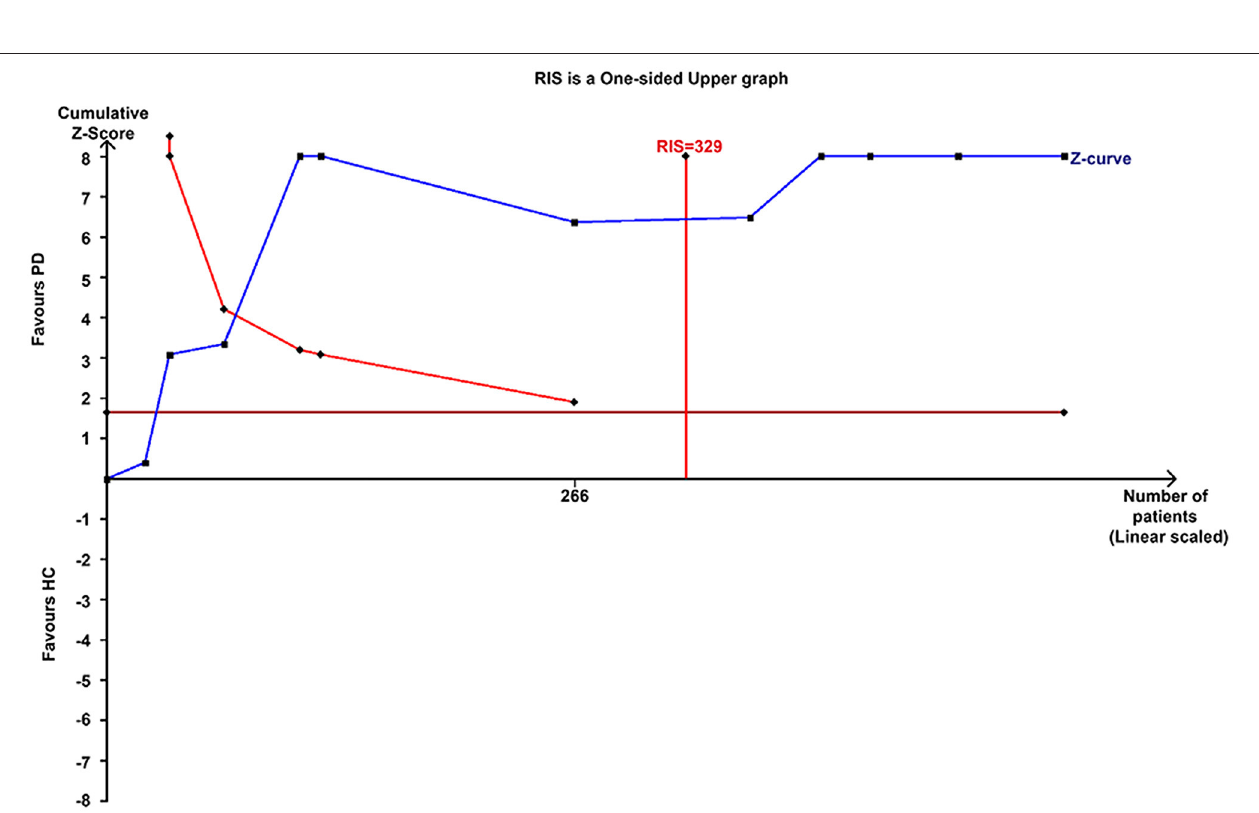
FIGURE 3 | Trial sequential analysis of the NAA-to-Cr ratio in GP.